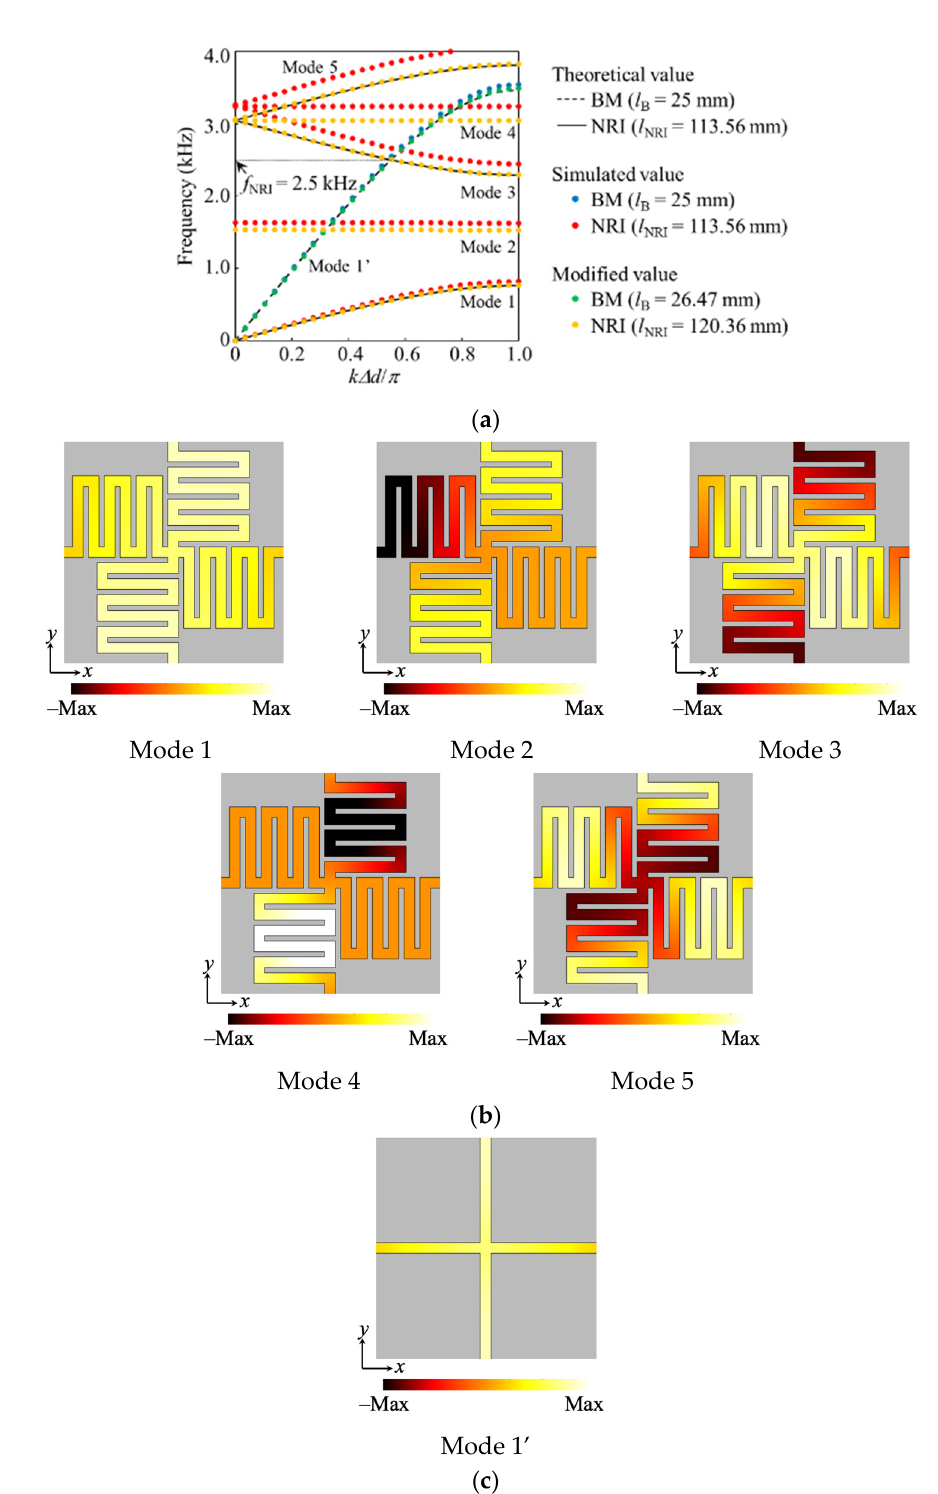
Figure 4. Calculated frequency dispersion characteristics for the NRI acoustic lens and the back- ground medium (BM) at the Γ -X pass ( k = k x and k y = 0), and modes of acoustic waves in the acoustic waveguide. ( a ) Dispersion characteristics; ( b ) Distributions of instantaneous values of the sound pressure of modes of 1–5 in ( a ); ( c ) Distributions of instantaneous values of the sound pressure of mode 1’ in ( a ). The intersection of the solid line and the broken one in ( a ) corresponds to the operating frequency of the NRI acoustic lens. The propagation direction of ( b ) assumes x